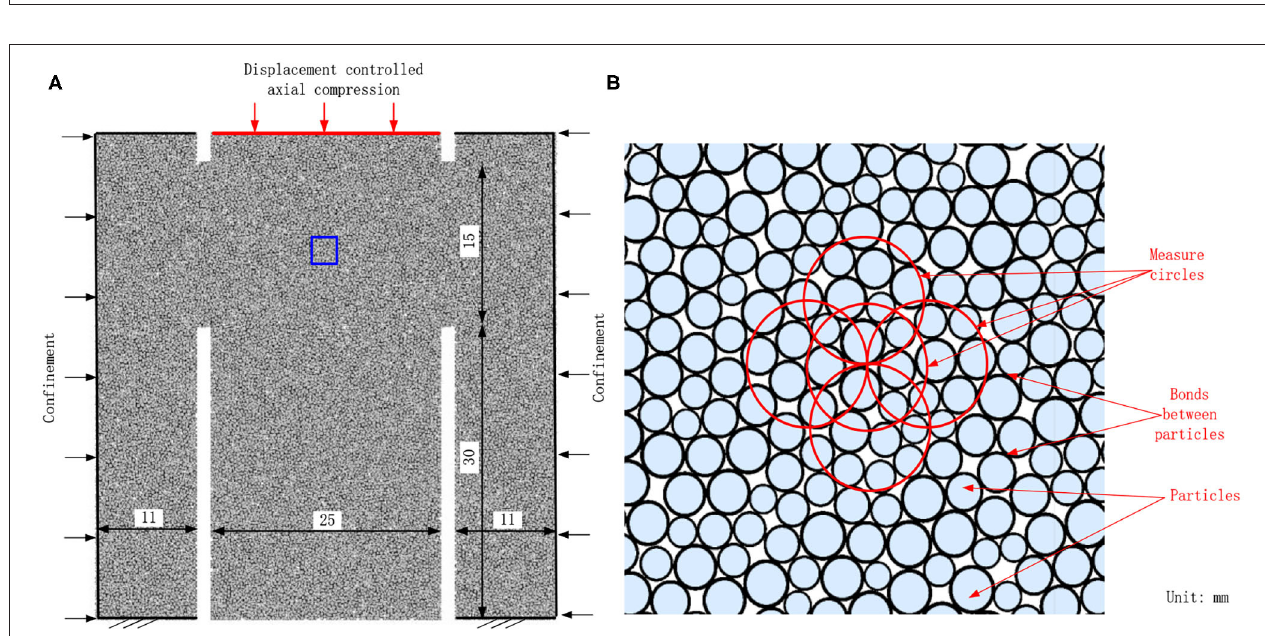
FIGURE 3 | Details of the numerical model: (A) is the geometry and the loading schematic of numerical model, and (B) is the magnified picture of the blue rectangle.